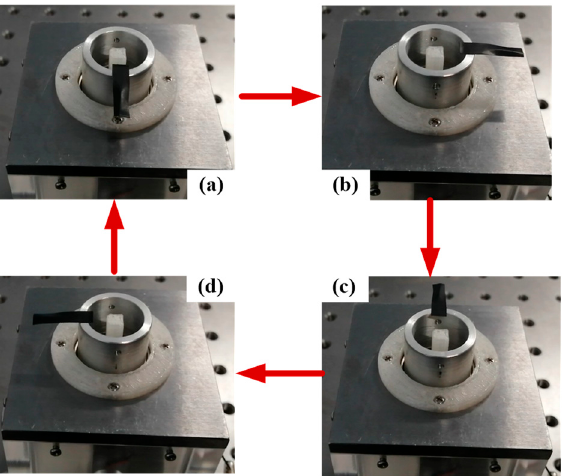
Figure 15. Prototype experimental diagram at different rotation positions. ( a ) Initial position; ( b ) 1/4 circle position; ( c ) 1/2 circle position; ( d ) 3/4 circle position.